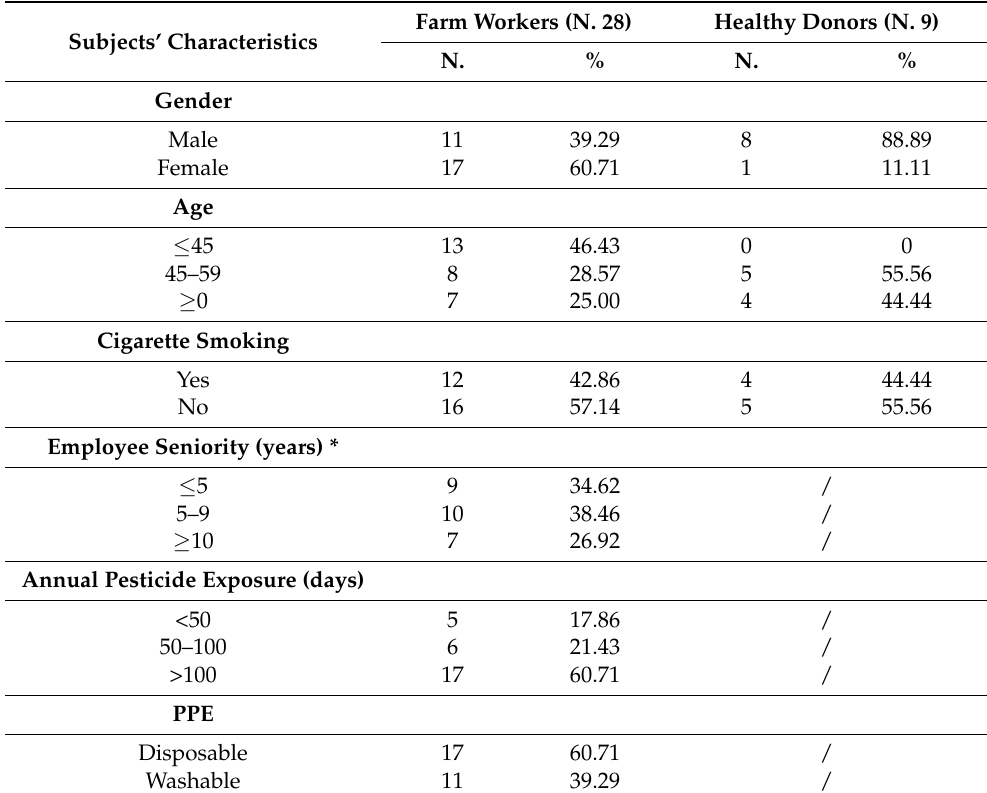
Table 1. Clinical features and time exposure of farm workers chronically exposed to pesticides. * Missing